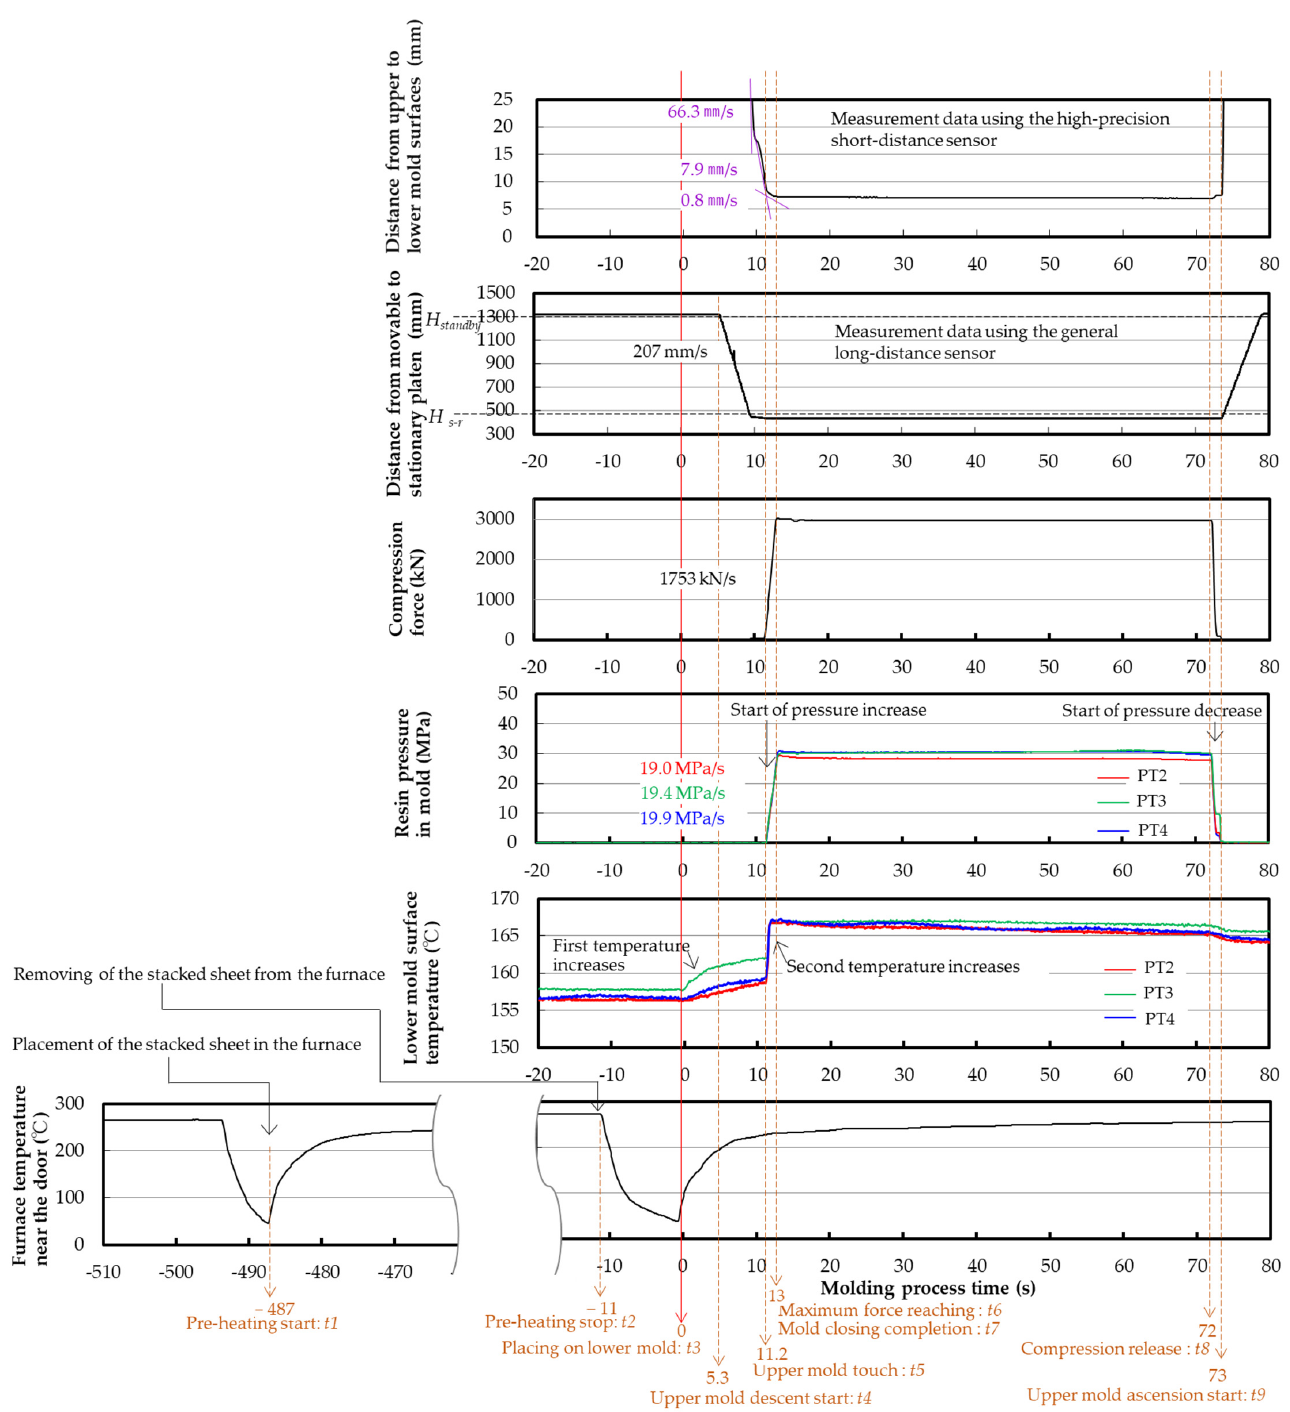
Figure 8. Logged data in the compression molding process using the test equipment and the monitoring system when the final stacking pattern A and the mold A were used as test case 1. The time when the sheet was placed on the lower mold was set to 0 s. ([Pressure increase rate] red: PT2, green: PT3, blue: